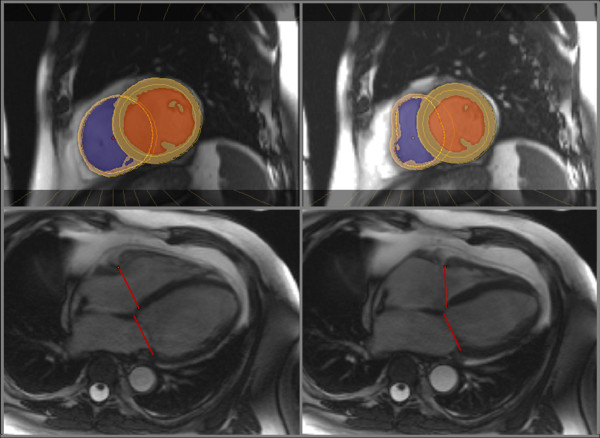
Software used for ventricular volumes and mass measurements. Mid-ventricular short-axis (top) and four-chamber views (bottom) at end-diastole (left) and end-systole (right). Coloured areas represent the left and right ventricular cavities and myocardium. Ventricular volumes are generated from a short-axis stack after being confined by the mitral and tricuspid valve planes (red lines).